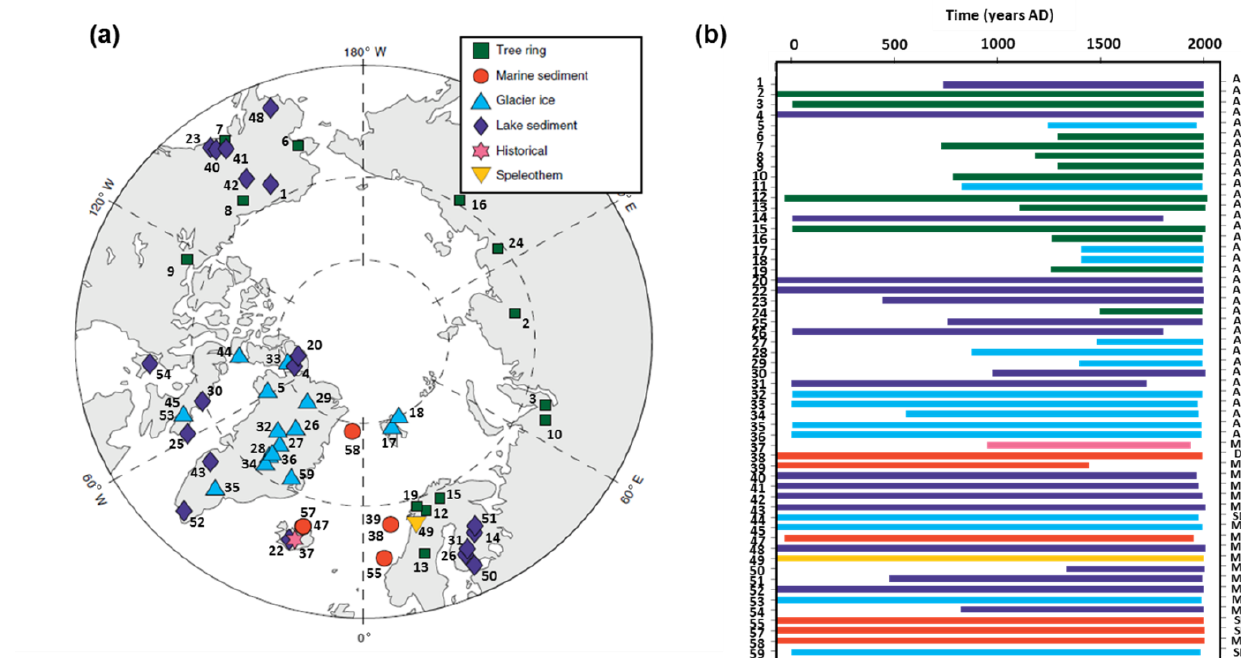
Figure 1. Paleoclimate series used for this study. (a) Polar projection of the proxy records location contained in the PAGES Arctic 2k database v1.1.1 (from McKay and Kaufman, 2014). (b) Temporal coverage and resolution (A: annual; SD: subdecadal; D: decadal; MD: mul- tidecadal) of the records from AD0 to AD2000. Letters with an asterisk indicate a mean temporal resolution. Colors correspond to archive type and refer to the map legend and numbers in the Arctic 2k database